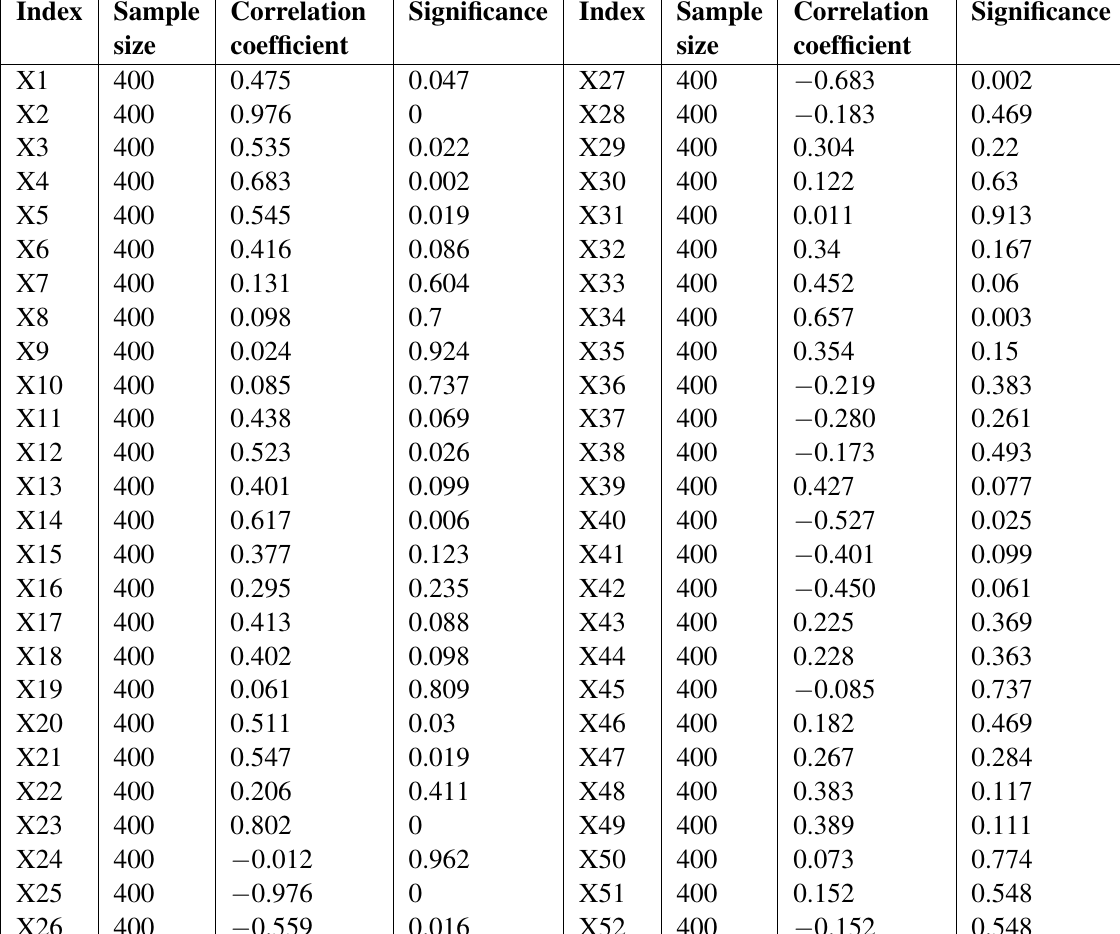
Table 4 The correlation between the outcome of the game and the